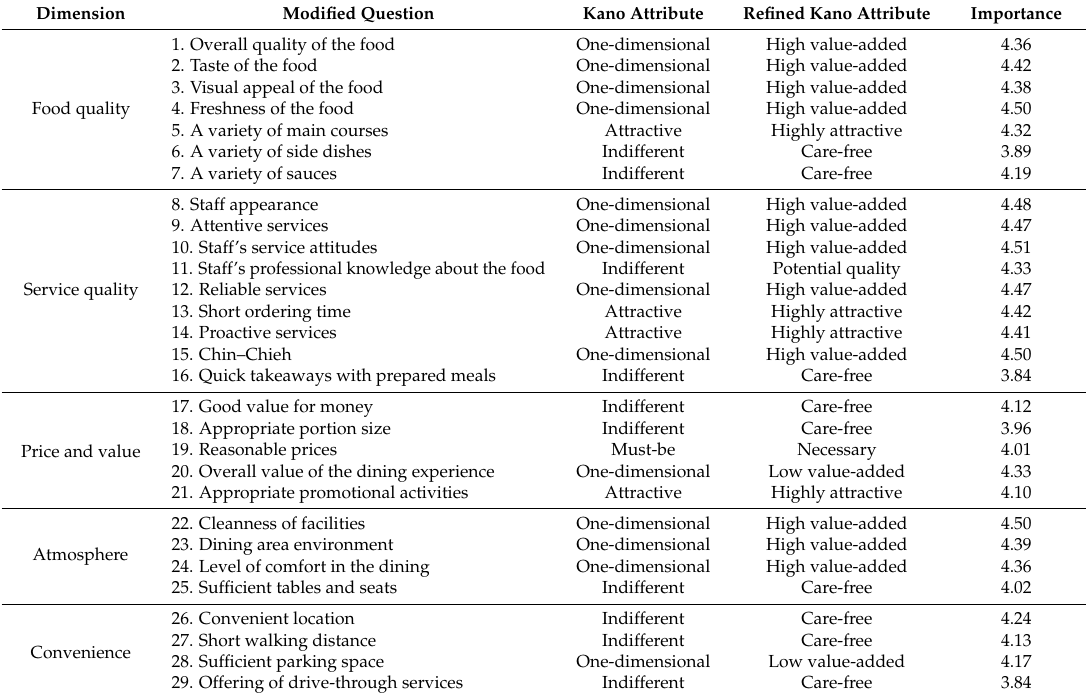
Table 6. Quality attribute